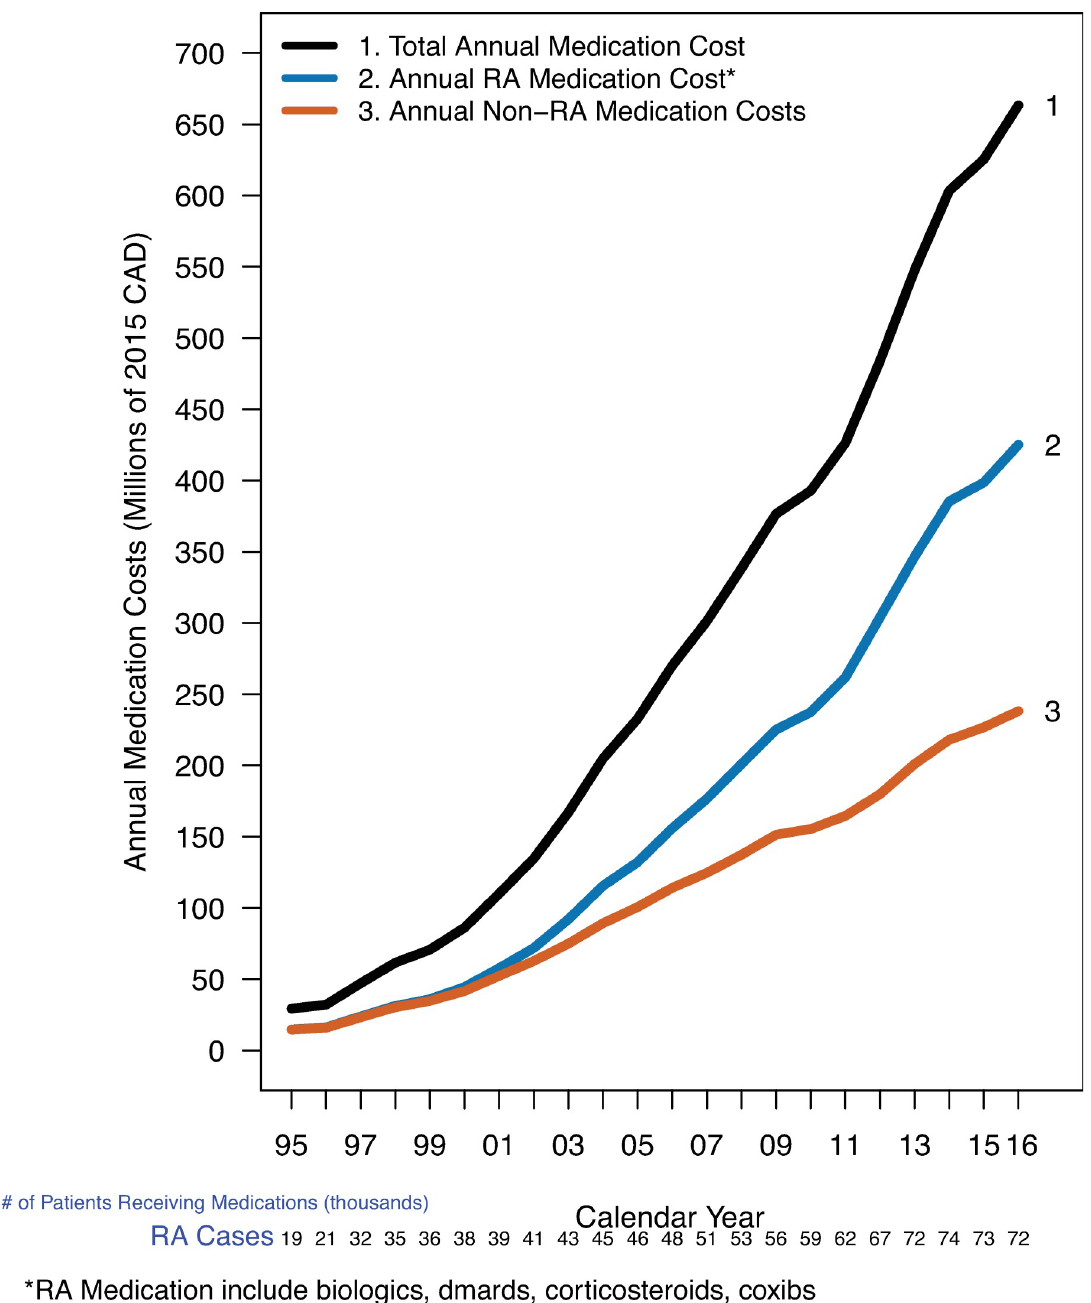
Fig 6. Total annual RA medication costs over time grouped by RA vs. Non − RA medications. X-axis: Calendar year, Y-axis: Annual Medication Costs (Millions of 2015 CAD), Grouping Variable: Medication Category).